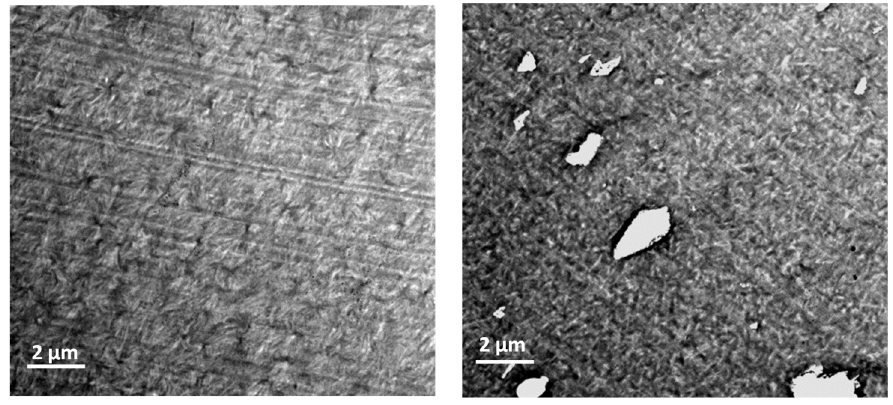
Figure 5. TEM micrographs of neat PPS ( left ) and PPS_imCl ( right ) (scale bar = 2 μ